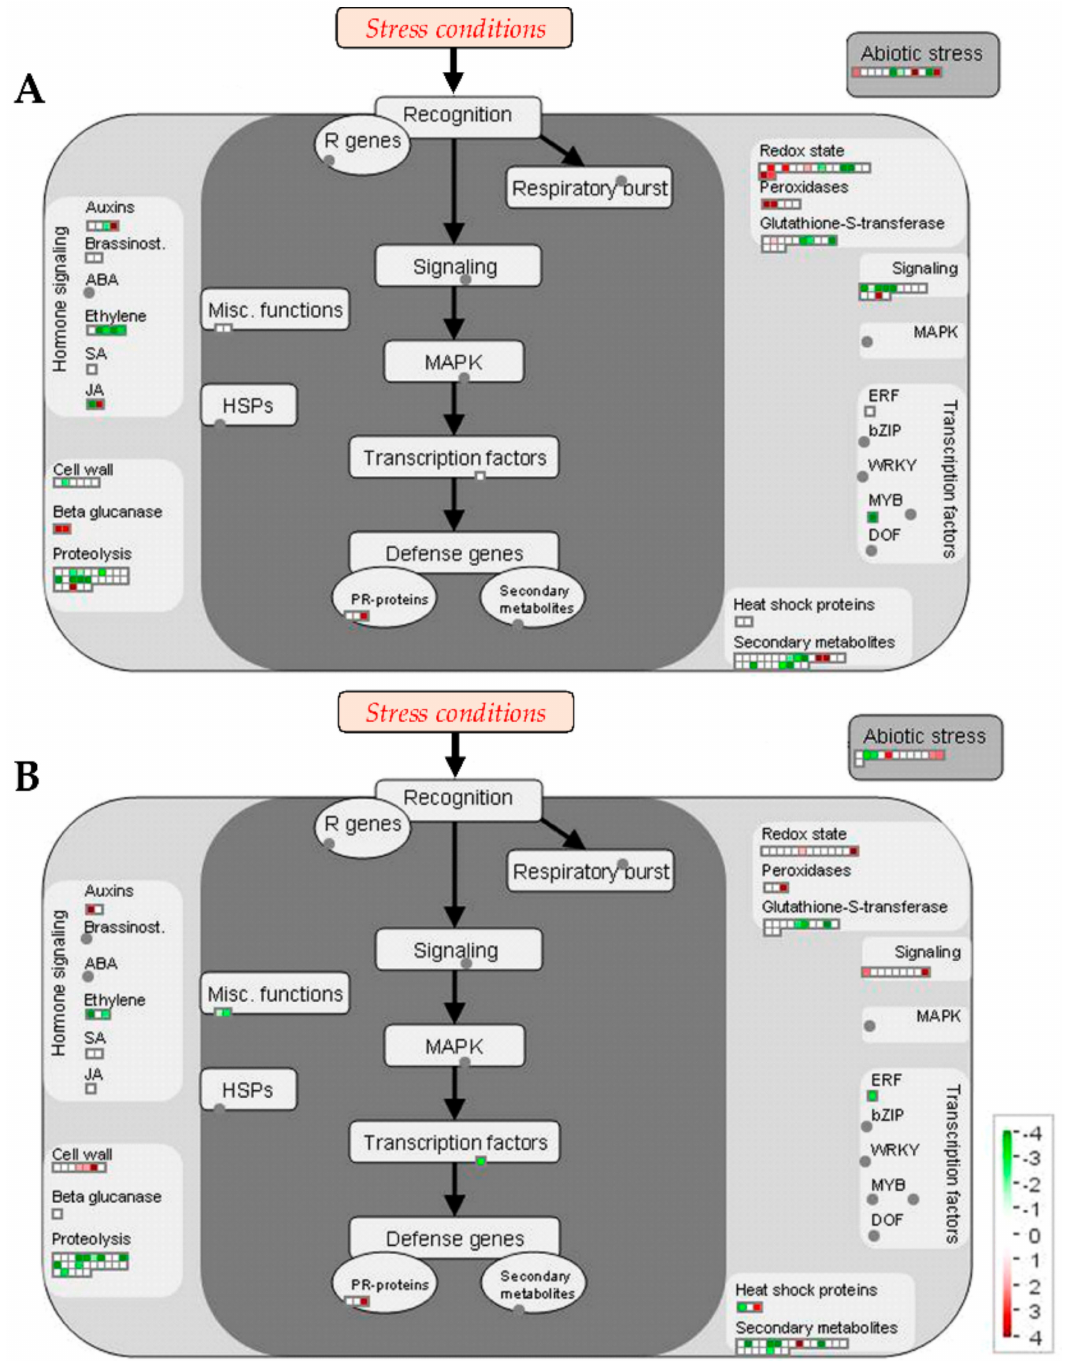
Figure 4. Changes in the MapMan overview related to stress pathways induced by salt stress. Changes in protein abundances (salt stress versus control) occurring in 101.14 ( A ) and M4 ( B ) grapevine rootstocks. Values are given in logarithmically scaled (base 1.2) signal intensities: red, increase; white, no change; green, decrease (see color